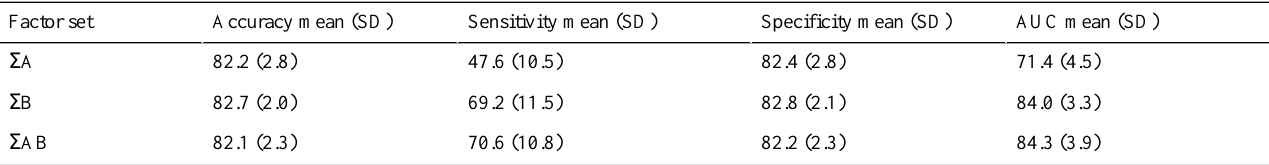
Table 5. Mean performance of different factor